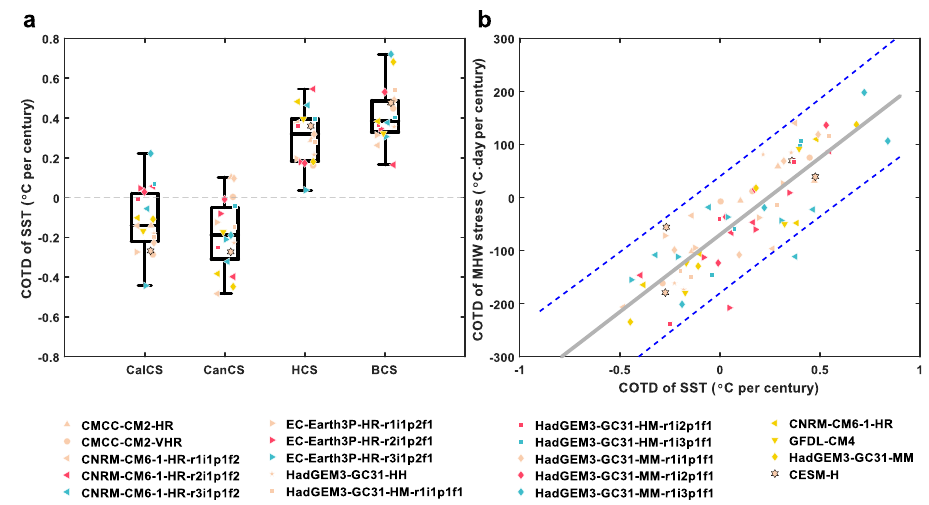
Fig.2|Comparisonoftheprojectedmarineheatwave(MHW)stressandmean- state sea surface temperature (SST) changes in the eastern boundary upwel- ling systems (EBUSs) under greenhouse warming between CESM-H and high- resolution coupled global climate models (CGCMs) in CMIP6. a Boxplots of coastal and oceanic trend difference (COTD) of mean-state SST in the individual